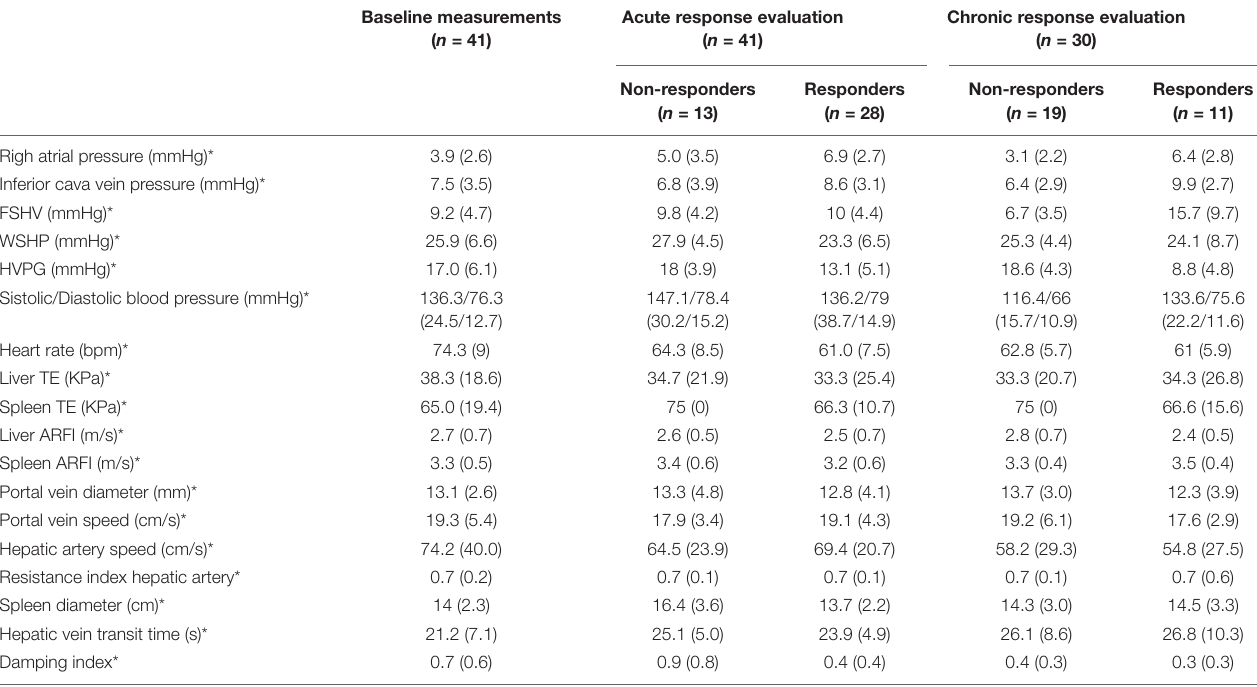
TABLE 2 | Baseline and follow-up invasive and non-invasive measurements after acute and chronic response to the beta-blockers evaluation.